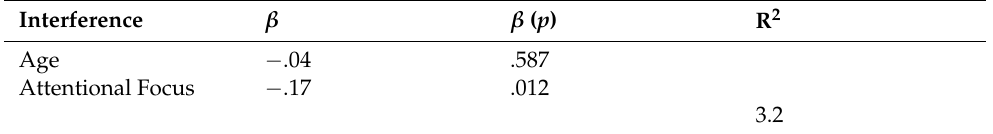
Table 5. Stepwise regression predicting Hearing difficulties from children’s Attentional Focus, Impulsivity, Inhibitory Control and Activation Control, with Age as a control variable (Study 2). Hearing Difficulties β β ( p ) R 2 Age − .01 .909 Activation Control − .24 <.001 n = 220. Table 6. Stepwise regression predicting noise Annoyance from children’s Attentional Focus, Impul- sivity, Inhibitory Control and Activation Control, with Age as a control variable (Study 2). Annoyance β β ( p ) R 2 Age − .02 .750 Attentional Focus − .21 .002 n = 216. Table 7. Stepwise regression predicting noise Interference from children’s Attentional Focus, Impul- sivity, Inhibitory Control and Activation Control, with Age as a control variable (Study 2). Interference β β ( p ) R 2 Age − .04 .587 Attentional Focus − .17 .012 n =